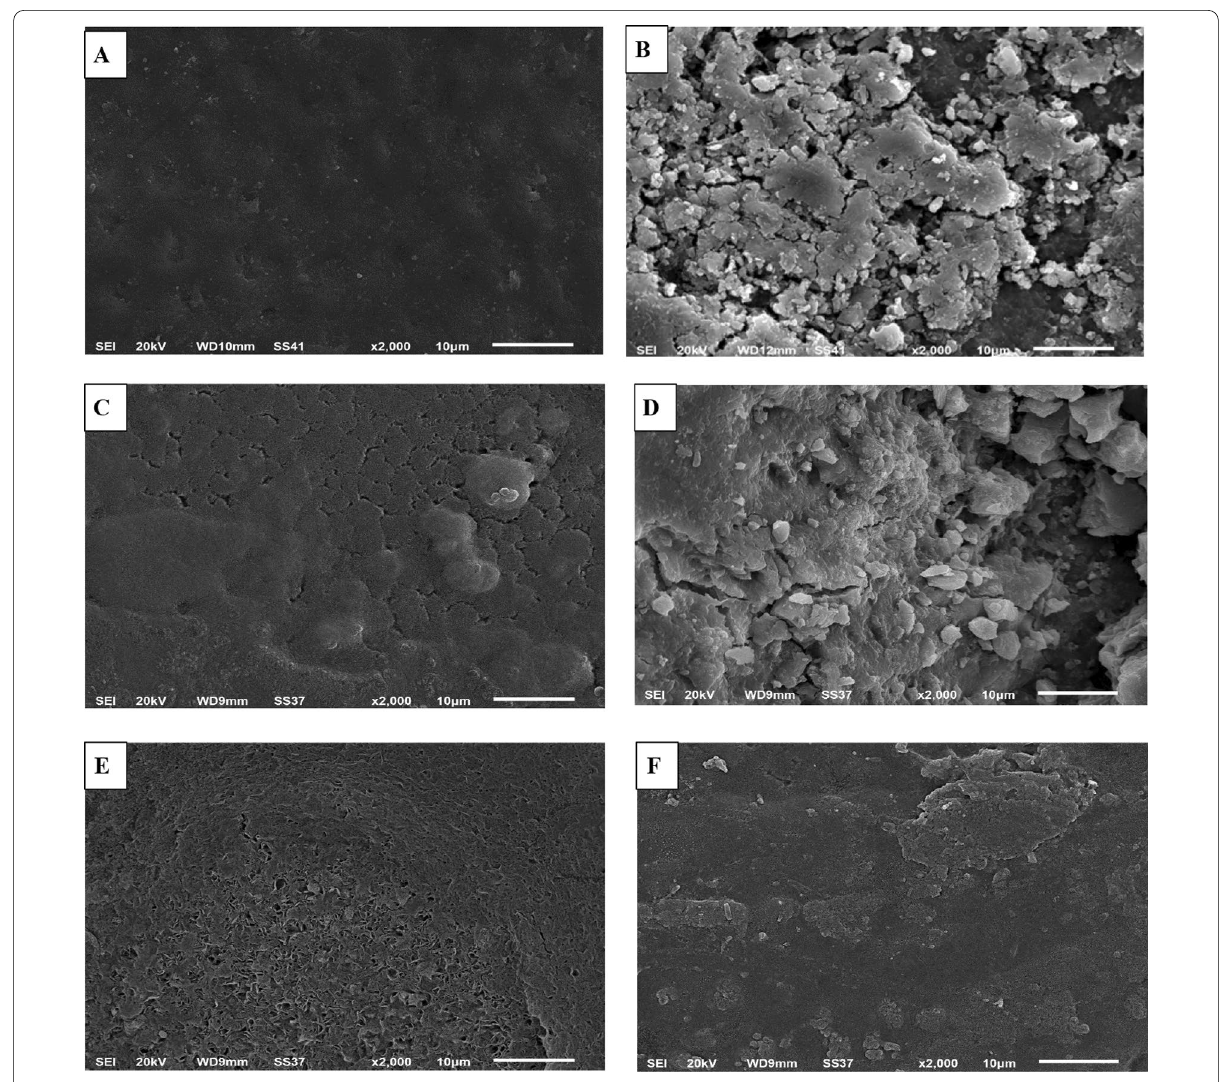
Fig. 5 Scanning electron micrographs ( 2000 magnification) of the different experimental groups; a Sound enamel, b Artificially-created white × spot lesion (demineralized enamel), c ICON resin-treated white spot lesion, d CPP-ACP-treated white spot lesion, e Universal adhesive resin-treated white spot lesion, f CPP-ACP with subsequent universal adhesive resin-treated white spot